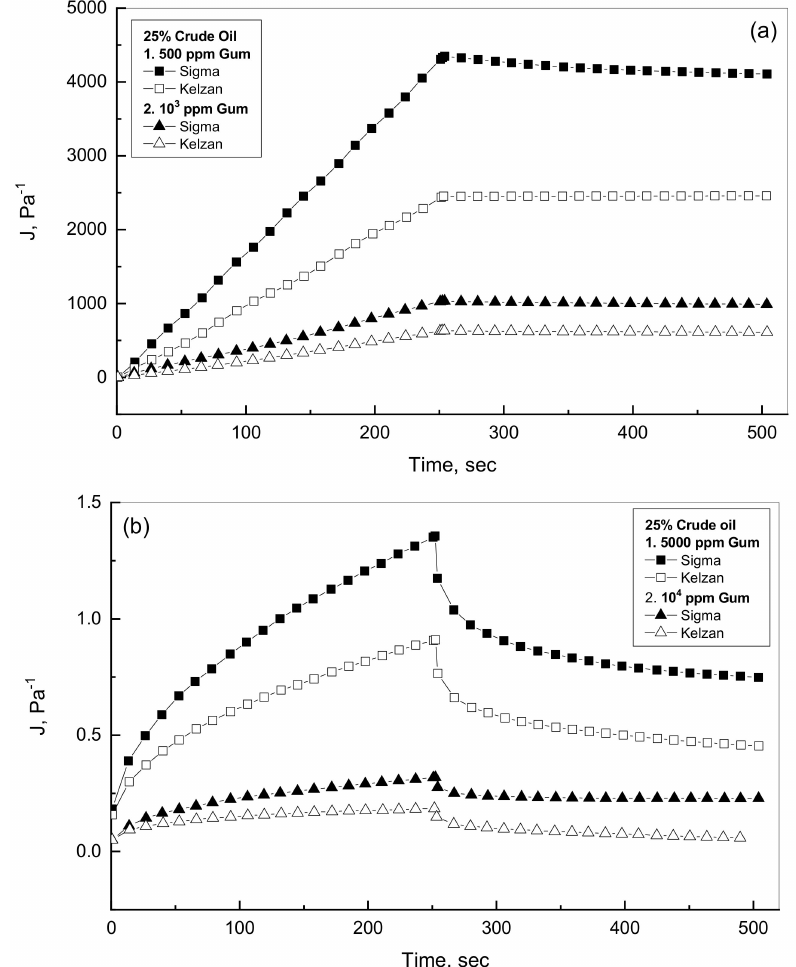
Figure 7. Creep-recovery behavior of Sigma and Kelzan for 25% oil emulsions. ( a ) Low Xanthan concentration; ( b ) High Xanthan